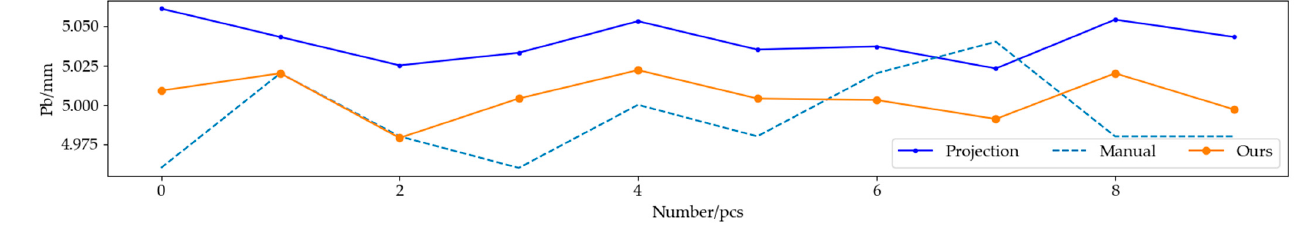
Figure 13. Graph of Pb measurement data.